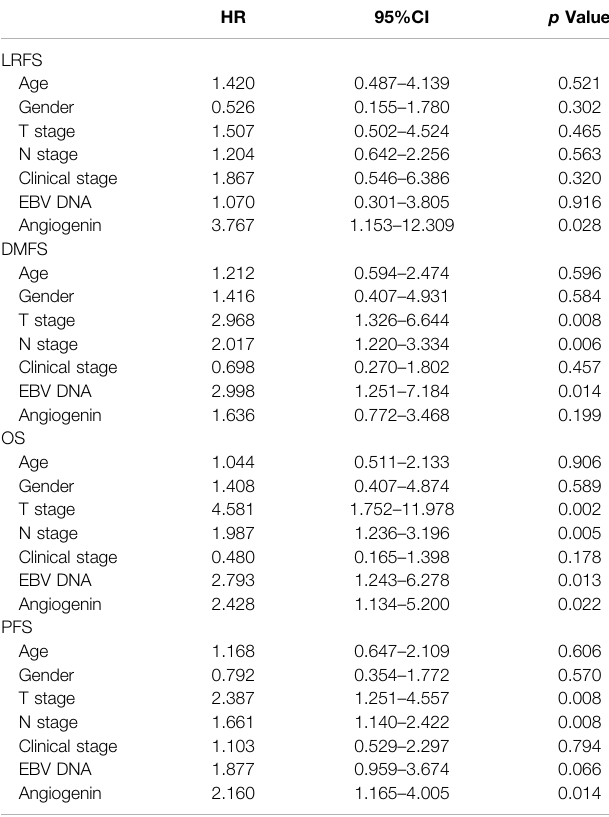
TABLE 2 | The multivariate analysis of Angiogenin in NPC